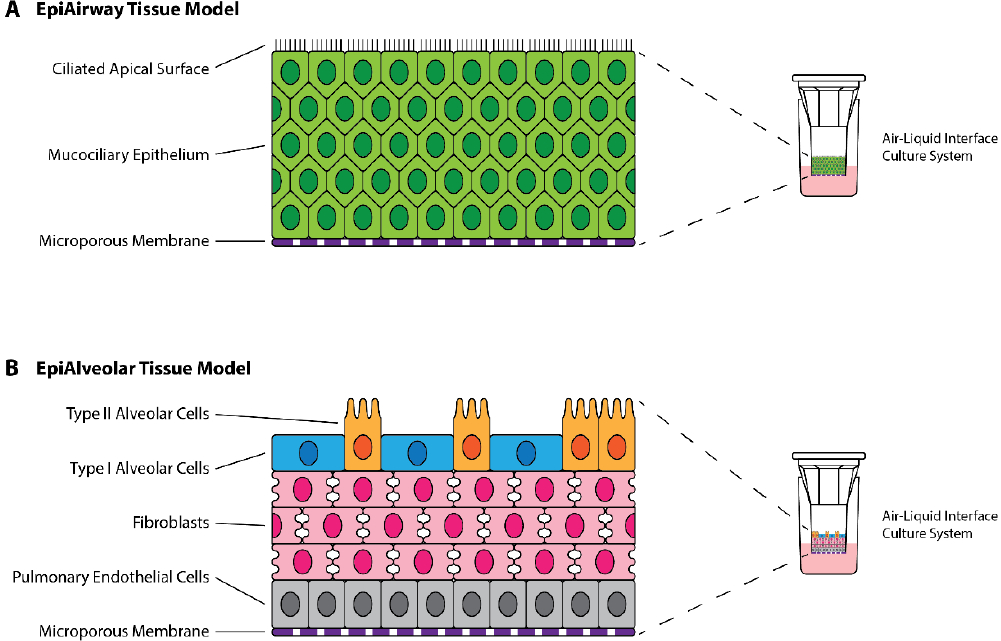
Figure 1. Structure of MatTek EpiAirway and EpiAlveolar 3D Tissue Models. ( A ) EpiAirway tissue model is composed of mucocilliary epithelial cells derived from normal human tracheal/bronchial epithelial cells (NHBE) differentiated at the air-liquid interface. ( B ) EpiAlveolar tissue model is composed of alveolar cells, fibroblasts and pulmonary endothelial cells derived from normal human alveolar epithelial cells (NHAE), normal human pulmonary fibroblasts (NHPF), and normal human pulmonary endothelial cells (NHPE) differentiated at the air-liquid interface. Colours are associated with cell types as labelled.